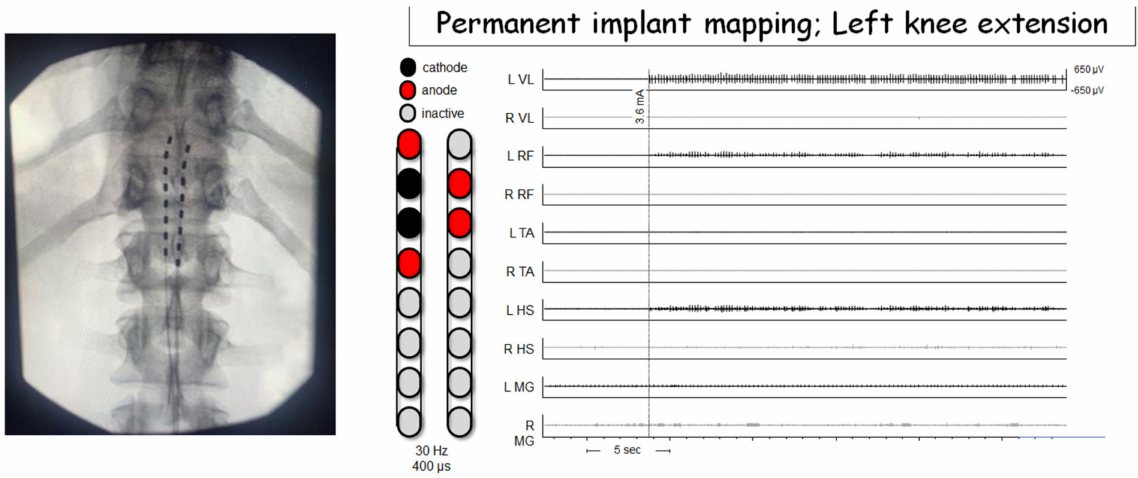
Figure 3. Epidural stimulation configuration for one participant resulting in left knee extension. All EMGs are shown on the same scale. Motor activity occurred at a stimulation amplitude of 3.6 mA. Phasic output is most prominent in knee extension muscles (L VL, L RF) with negligible activity at knee flexor muscles. Hz—hertz (stimulation frequency); µ s—microseconds; L—left; R—right; VL—vastus lateralis; RF—rectus femoris; TA—tibialis anterior; HS—hamstrings; MG—medial gastrocnemius; sec—seconds; µ